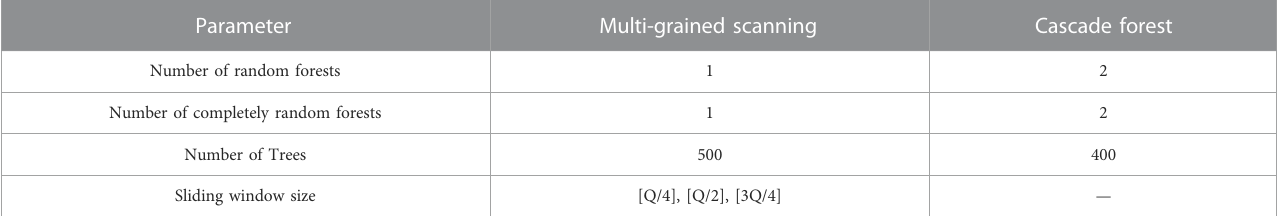
TABLE 5 Parameters setting of deep